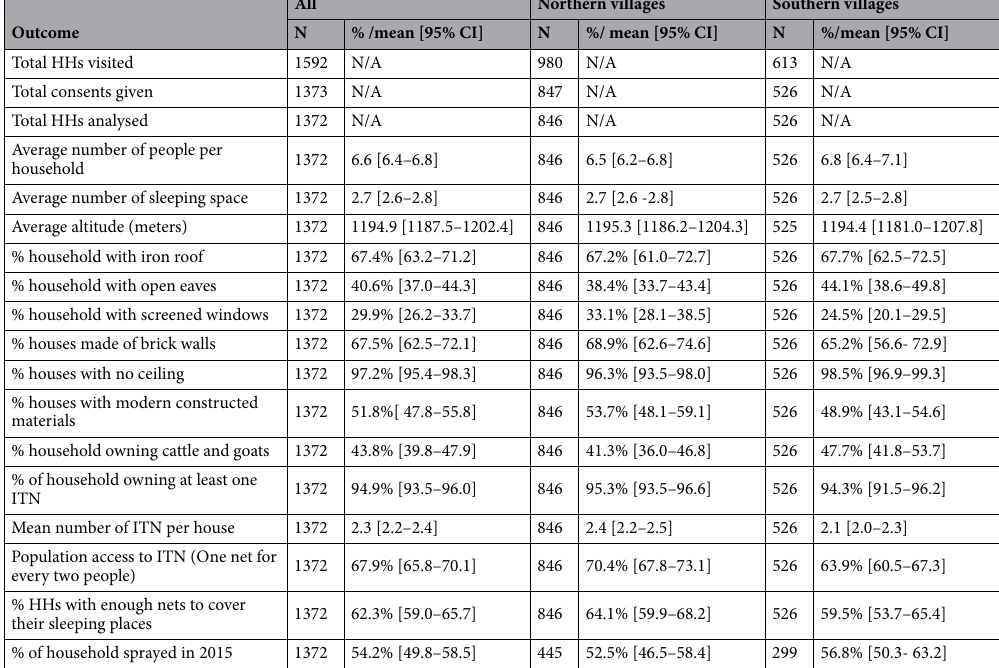
Table 1. Household characteristics in the study area in Northern and Southern clusters. The district spans two agro-ecological zones, based on vegetation land cover and rainfall (Fig. 1), that are divided roughly into northern and southern clusters. HH household, ITN insecticide-treated net, N/A not applicable.